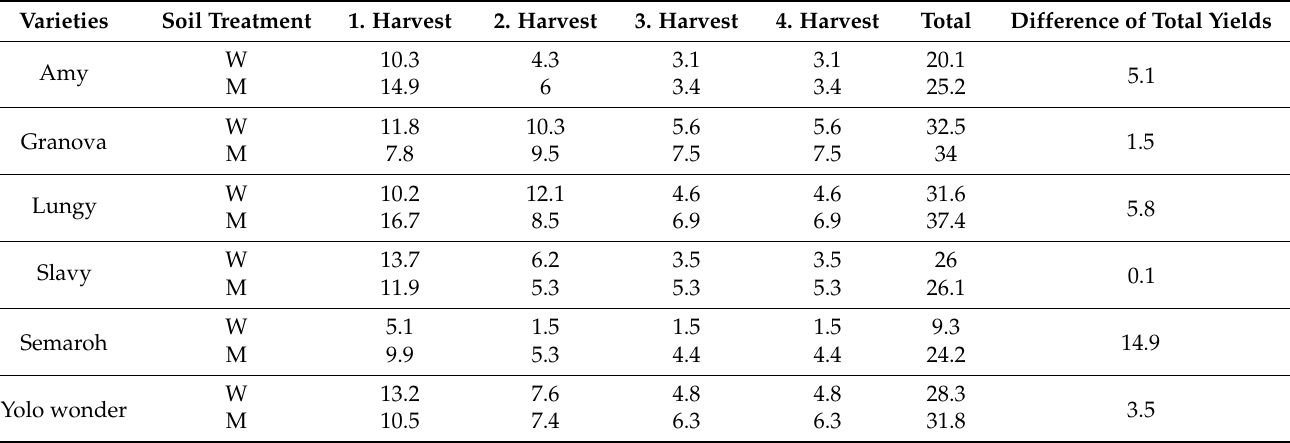
Table 8. Total yield of peppers at gradual harvests (t · ha − 1 ) and difference of total yields between soil